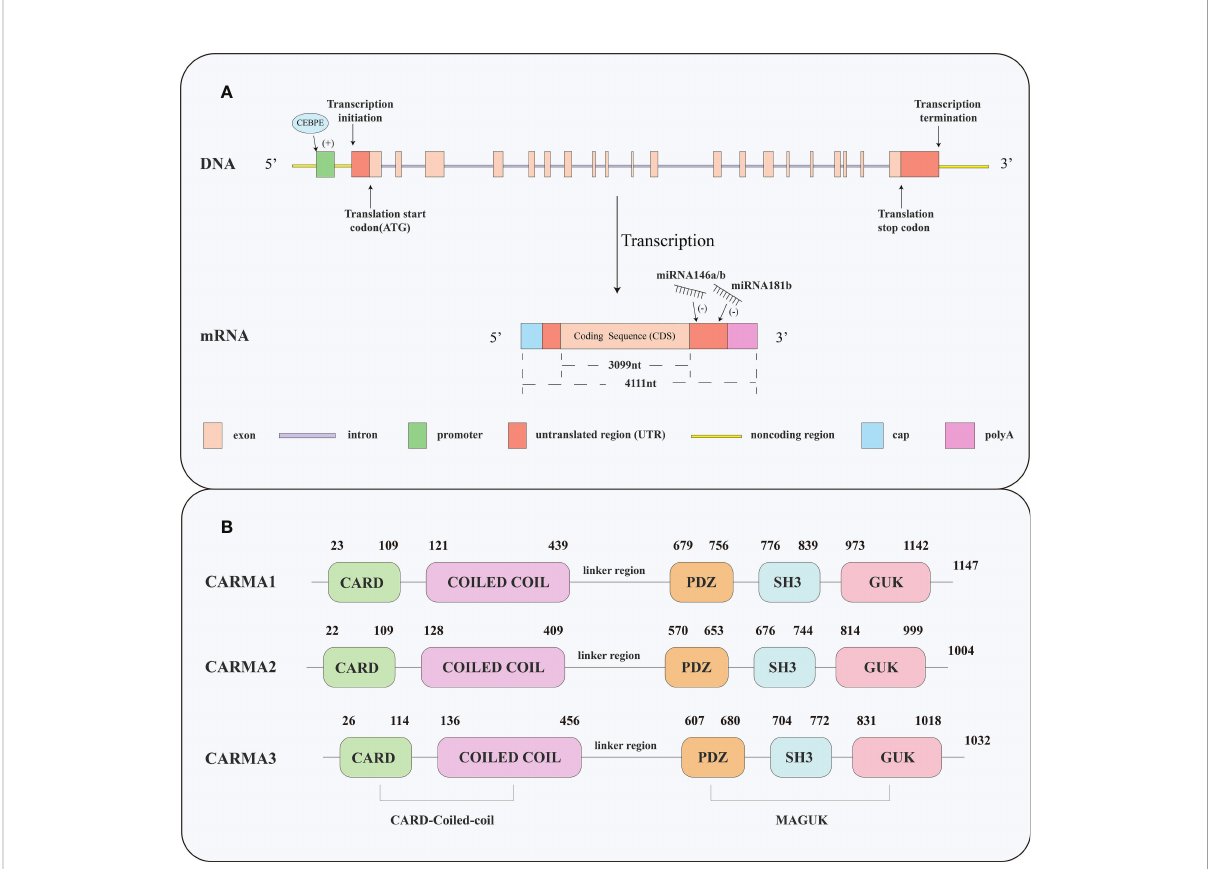
FIGURE 1 Gene structure of CARD10 and protein structures of CARMA1, CARMA2, and CARMA3. (A) The CARD10 gene consists of 20 exons. Its mRNA and CDS lengths are 4111 and 3099nt respectively. CEBPE is a transcription factor, that targets the promoter region of CARD10 . microRNA -146a/b and microRNA-181b regulate CARD10 by acting on the 3- ’ UTR of CARD10 mRNA. (B) All the three CARMA proteins are comprised of fi ve functional domains: a CARD domain, a CC domain, a PDZ domain, an SH3 domain, and a GUK